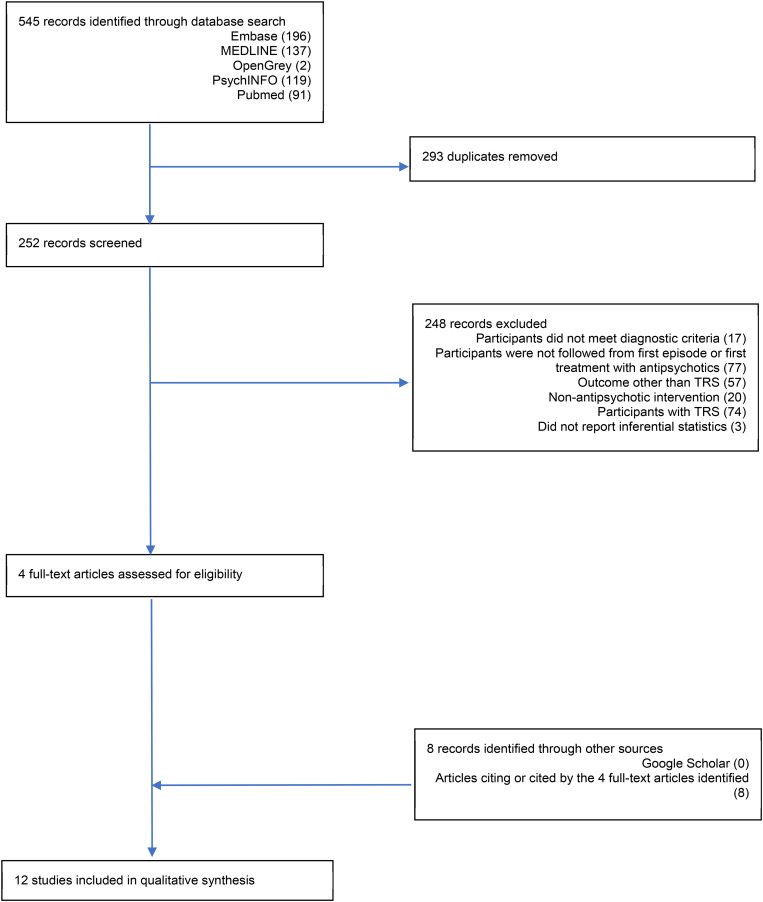
PRISMA flow diagram.